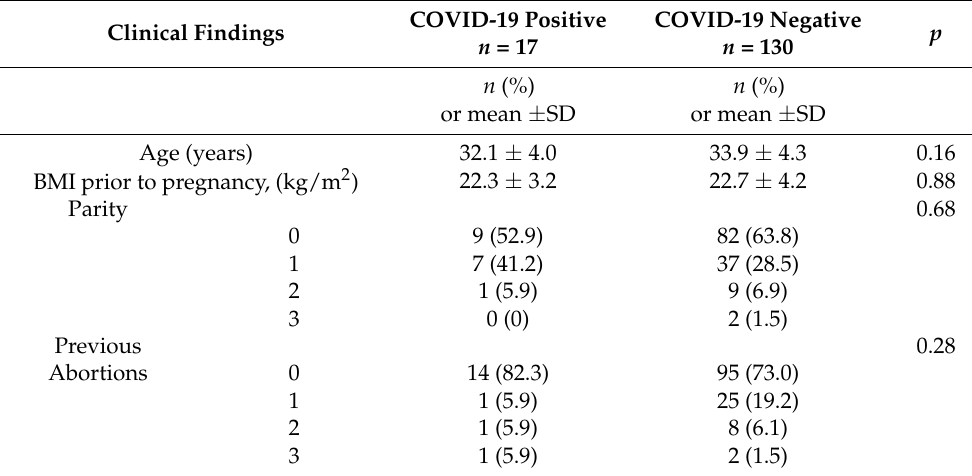
Table 1. Baseline characteristics, clinical findings in COVID-19-positive and -negative